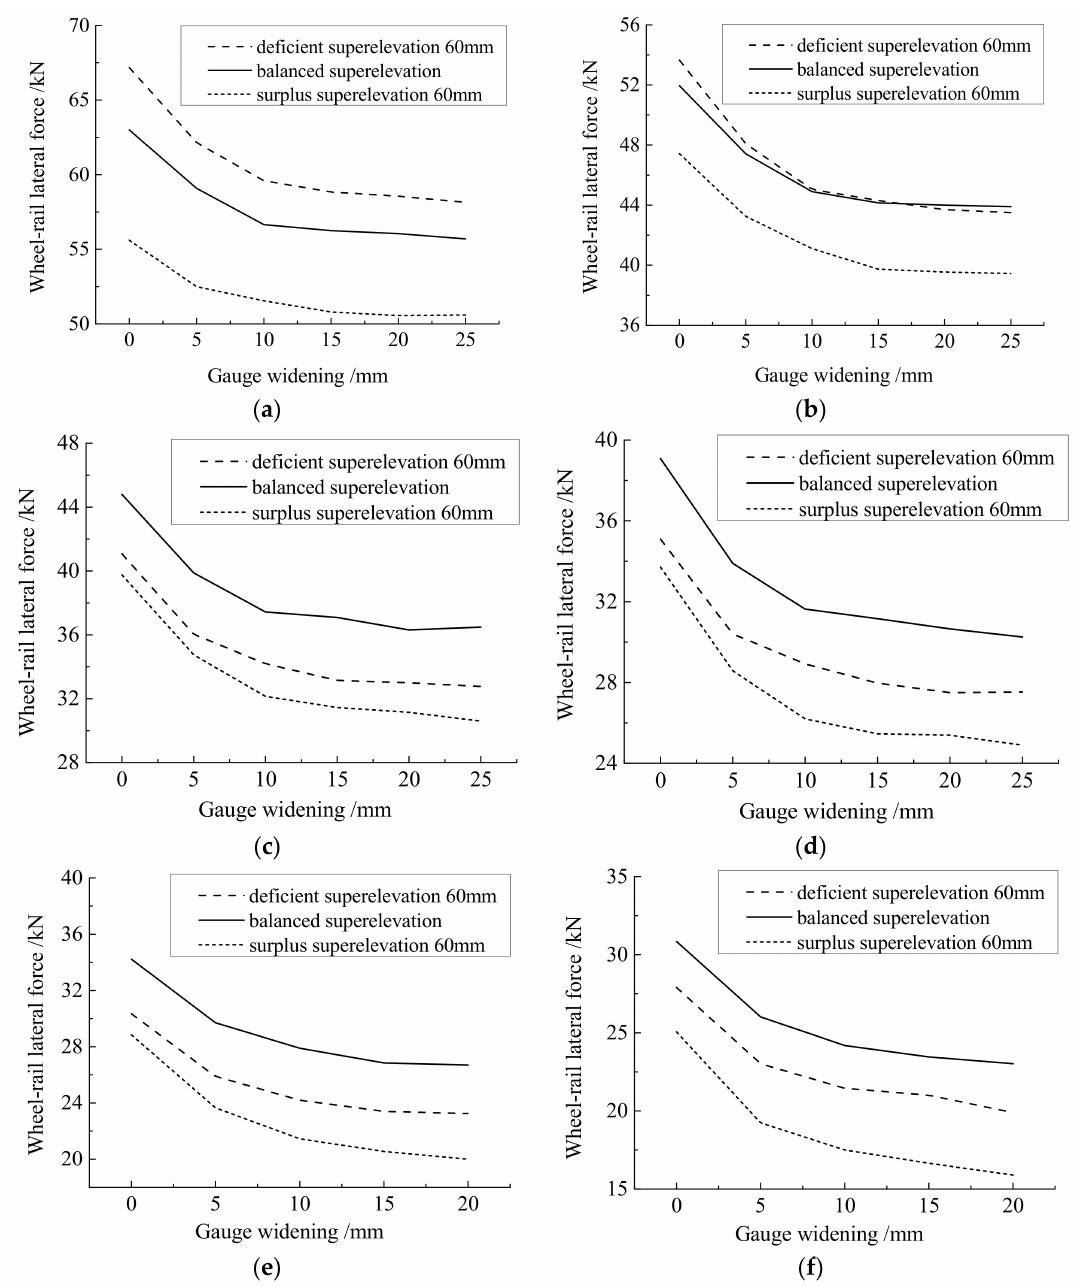
Figure 10. The influence of the gage widening value on wheel or rail lateral force. ( a ) R150 m; ( b ) R200 m; ( c ) R250 m; ( d ) R300 m; ( e ) R350 m; ( f ) R400